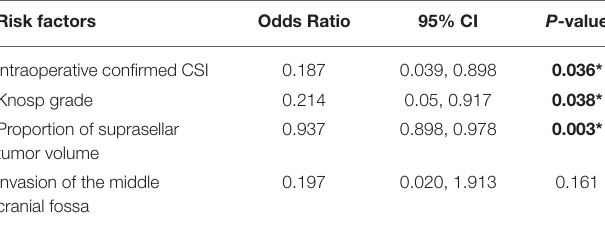
TABLE 4 | Binary logistic regression analysis of the risk factors affecting the degree of GPA resection.